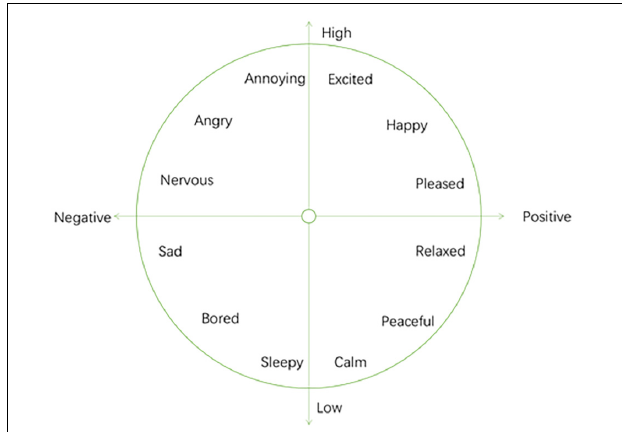
FIGURE 3 | VA emotional